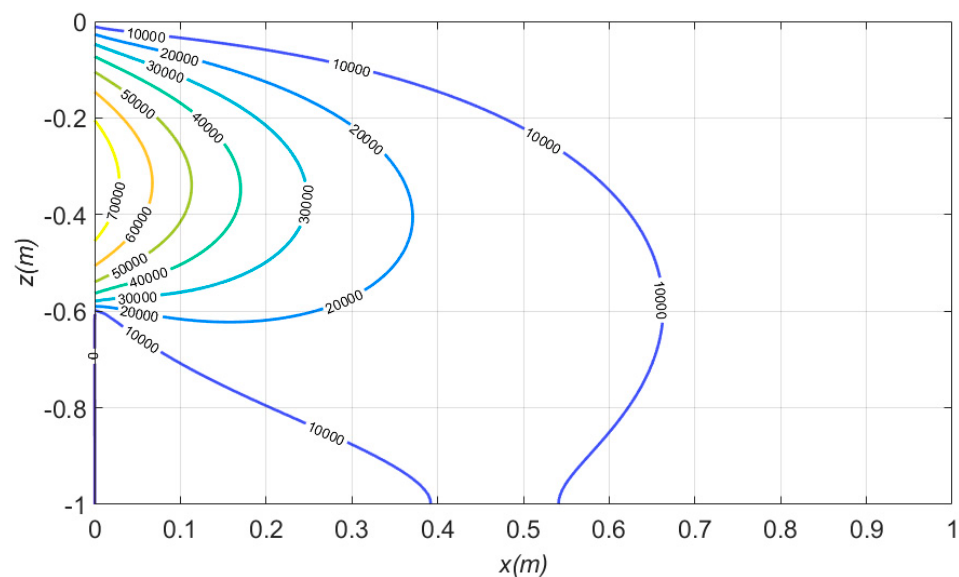
Figure 8. Contours of the hydrodynamic pressure in the liquid domain for fixed air cavity position − 1 ≤ z ≤ − 0.6, fixed wave impact velocity v = 300 and t = 0.01 s .